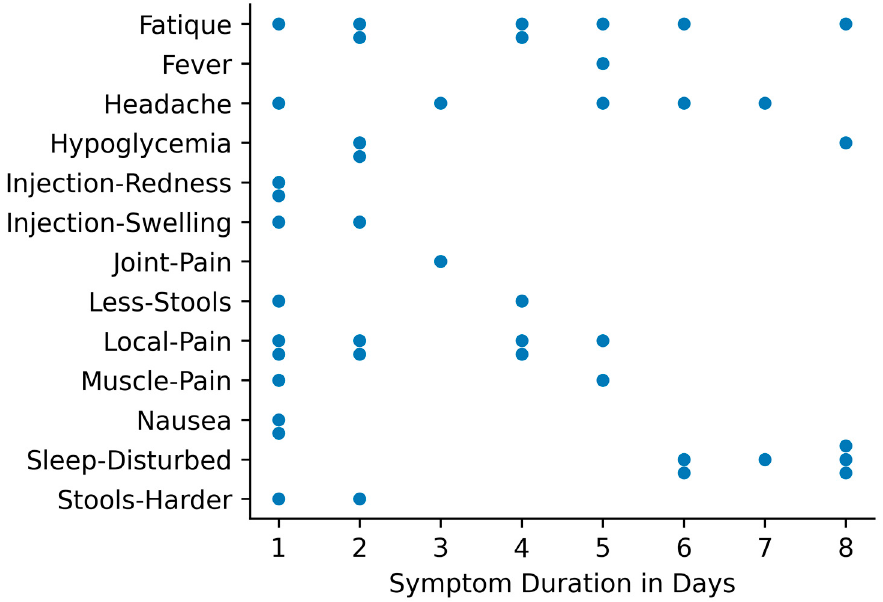
Figure 7. The duration of symptoms documented during the intensive monitoring phase is shown. Each data point represents a patient with the respective symptom indicating the duration of the symptom.